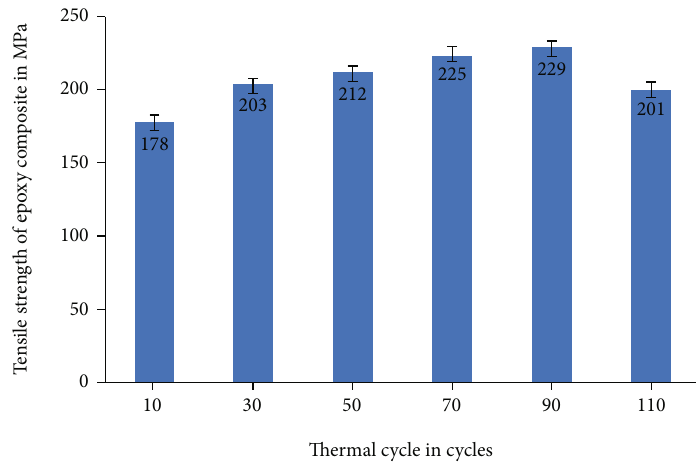
Figure 6: Tensile strength of epoxy composite with various thermal